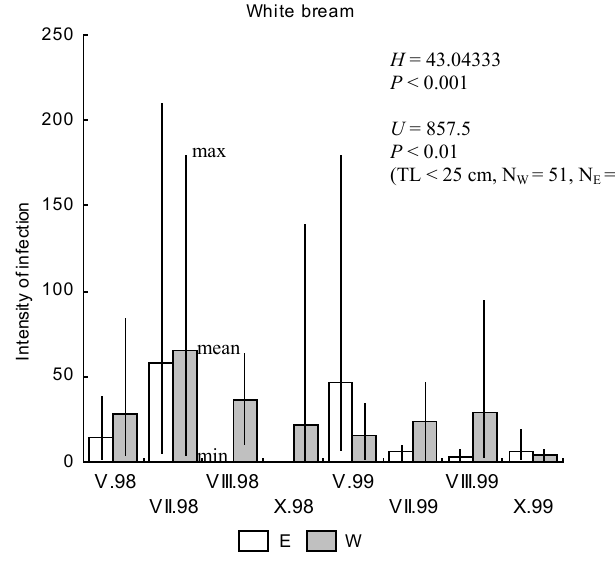
Fig. 5. Intensity of infection of white bream with P. cuticola in samples from eastern- (E) and western (W) part of OÊwin Lake. H , Kruskal-Wallis statistic for seasonal differences. U , Mann-Whitney statistic for location